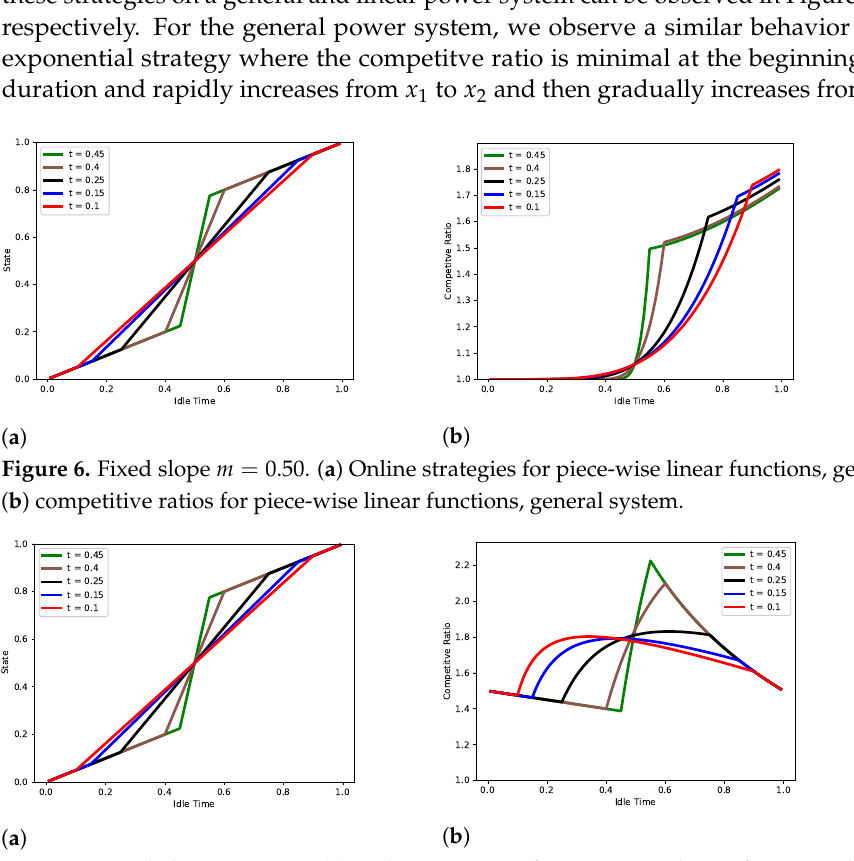
Figure 7. Fixed slope m = 0.50. ( a ) Online strategies for piece-wise linear functions, linear system; ( b ) competitive ratios for piece-wise linear functions, linear